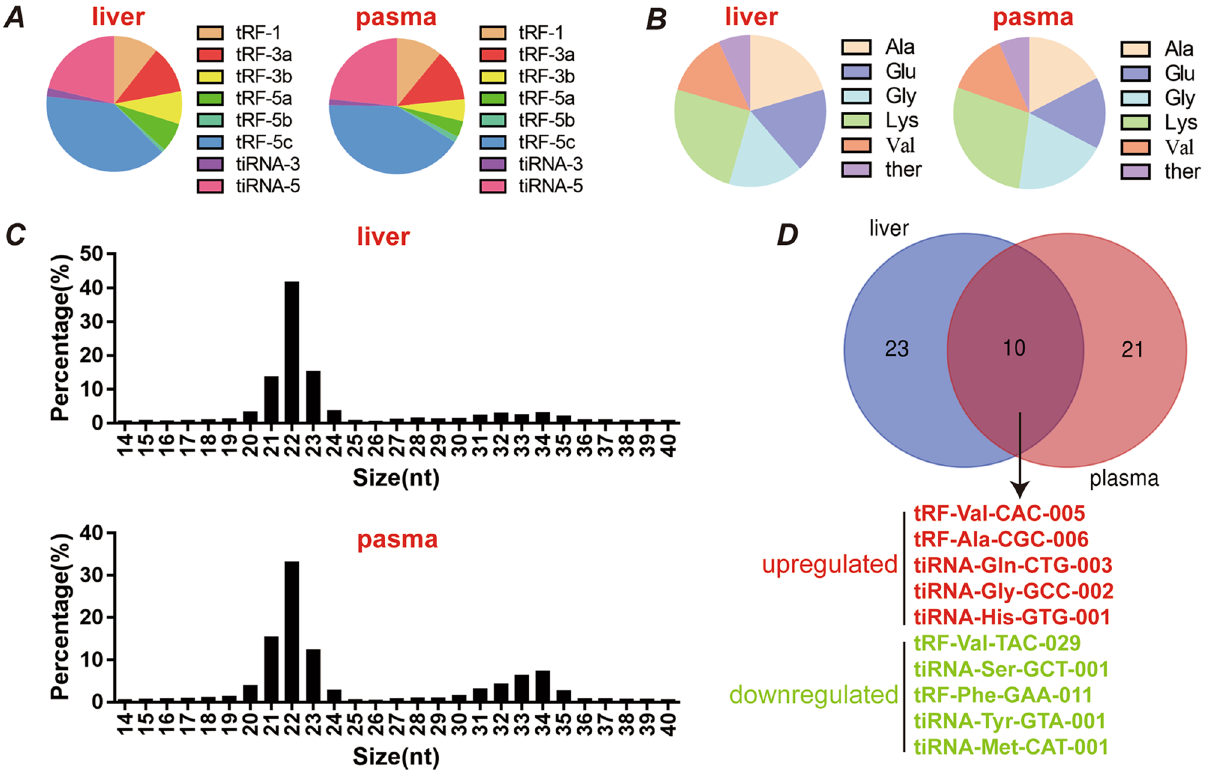
Figure 1. The characteristics of the differentially expressed tsRNAs in liver tissues or plasma are similar between patients with and without NAFLD. (A) Percentage of each type of tsRNA; (B) percentage of tsRNAs generated from Ala-, Glu-, Gly-, Lys- and Val-tRNAs; (C) length distribution of tsRNAs; (D) five upregulated and five downregulated tRNA-derived fragments were identified as differentially altered in the liver tissues and plasma of NAFLD patients relative to non-NAFLD